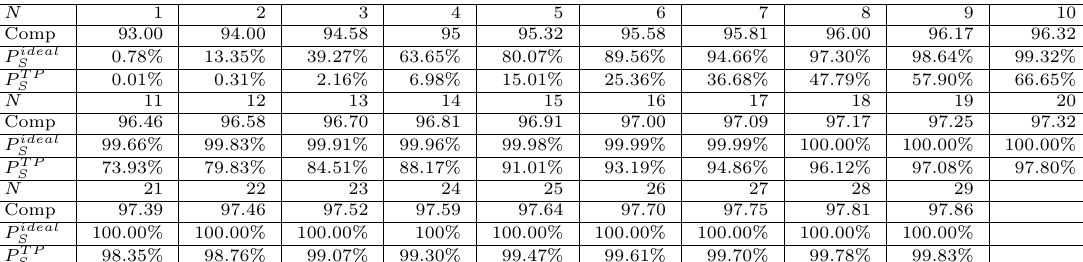
Table 4: The complexities and success probabilities for attacking 256-round Grain-128 using different cube number N ’s. P ideal